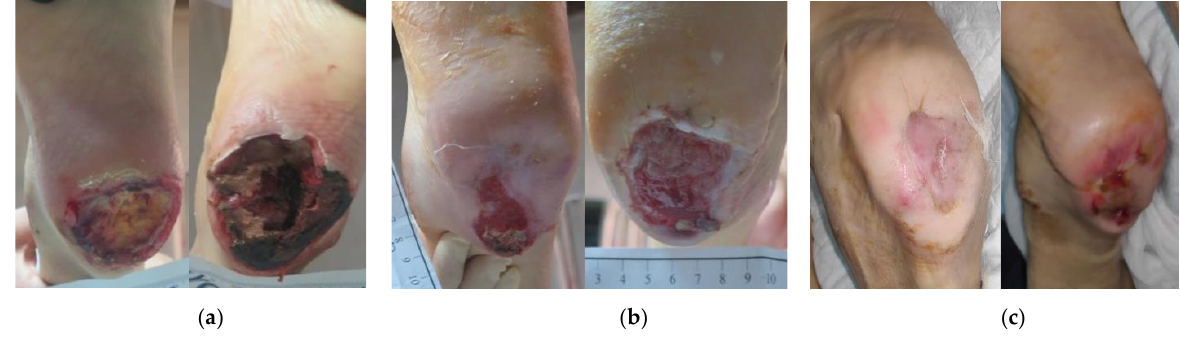
Figure 6. Case 6: ( a ) clinical findings at the initial examination, day 0 (start of MGH treatment); ( b ) MGH and serial surgical debridements lead to cleansing of the wound bed and progression of the wound healing after 8 weeks of treatment; ( c ) complete wound healing after 22 weeks of MGH ther- apy.